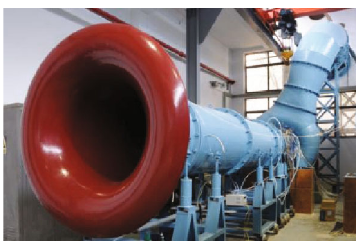
Figure 1: Test bench of the low-speed axial